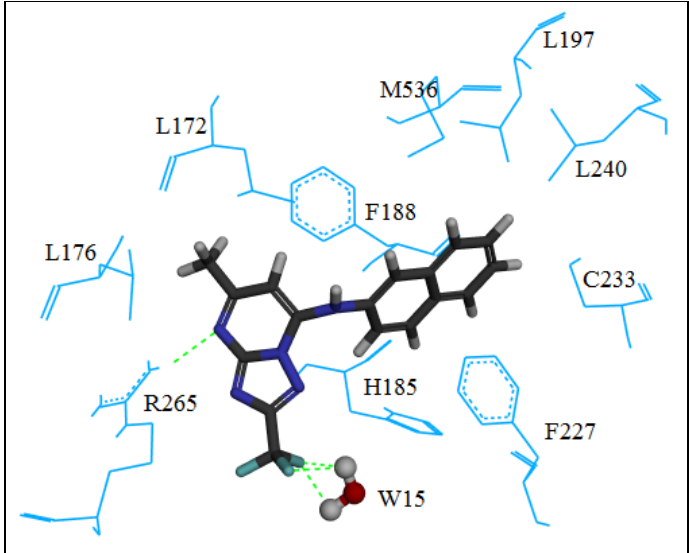
Figure 4. Compound 5 docked into the active site of Pf